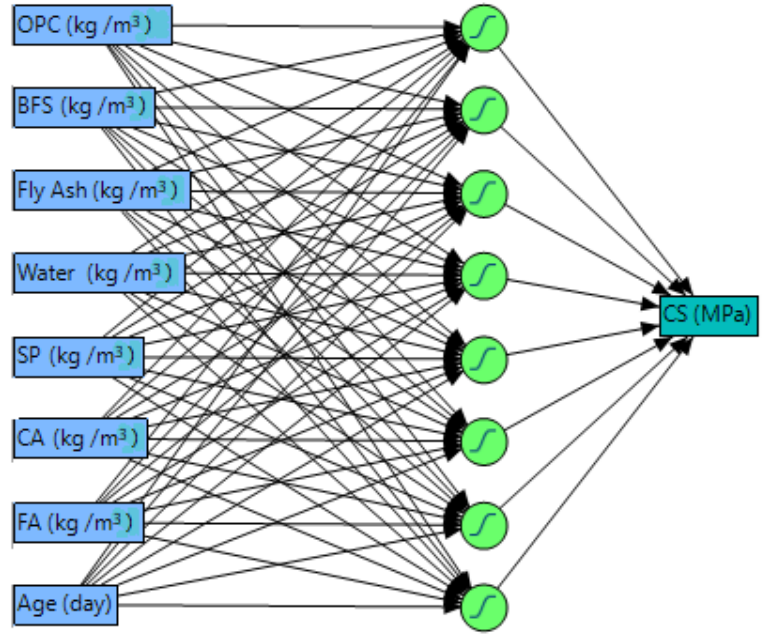
Figure 3. ANNs Diagram Using ANNs Modeling.